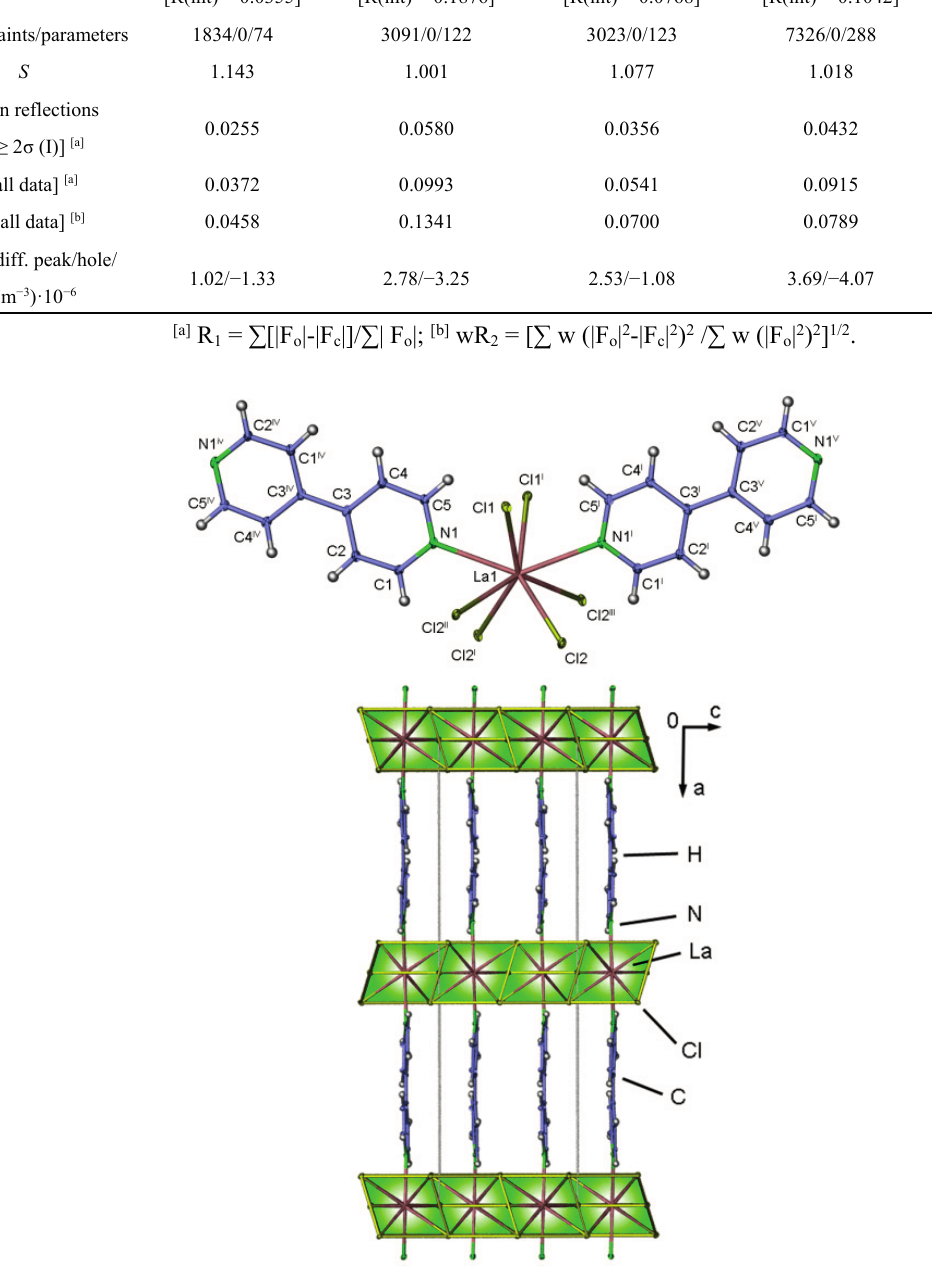
Figure 8. Coordination sphere with complete ligands of 3 ∞ [LaCl 3 (bipy)] ( 2 ) different in two alternating positions of Cl2 within the trigonal-prismatic coordination sphere of the La 3+ ion. Symmetry operations: I : 1 − x, y, ½ − z, II : 1 − x, 1 − y, − z; III : x, 1 − y, ½+z; IV : 3/2 − x, 2 − y, z; V : x − 1/2, 2 − y, ½ − z ( top ). View along the b-axis of the single-crystal structure of 3 ∞ [LaCl 3 (bipy)] ( bottom